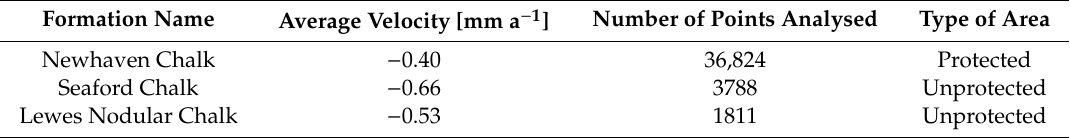
Table 2. Average velocity per annum for chalk formations exposed on the shore platform.